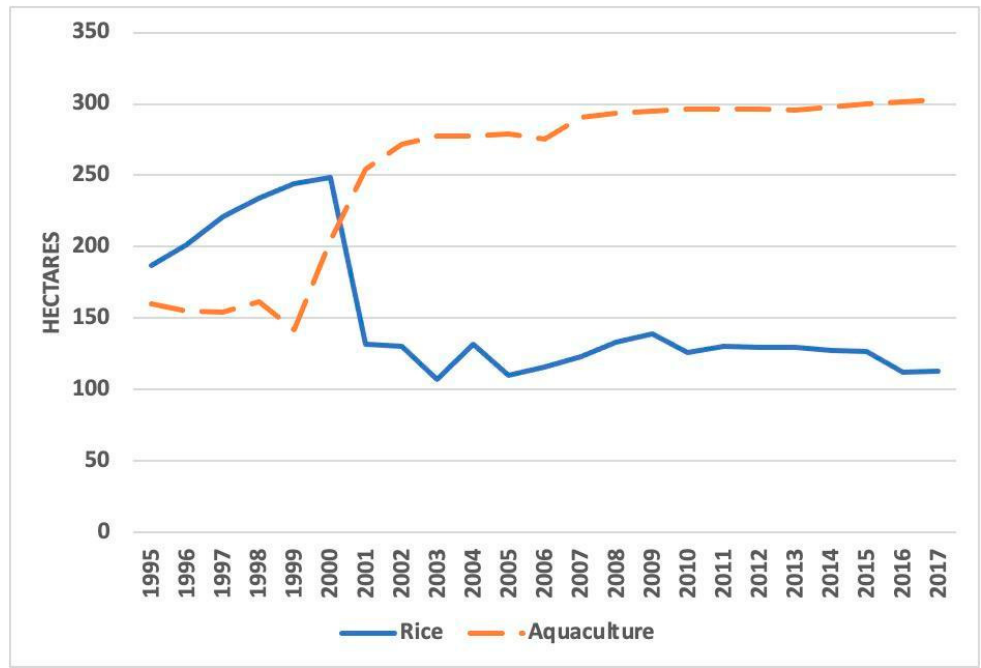
Figure 1. Use of agricultural land in Ca Mau Province, 1995–2017. Notice the sharp pivot between 1999 and 2002 induced by government incentives to shift production from rice to aquaculture (Decree 09/2000/NQ-CP) [20].